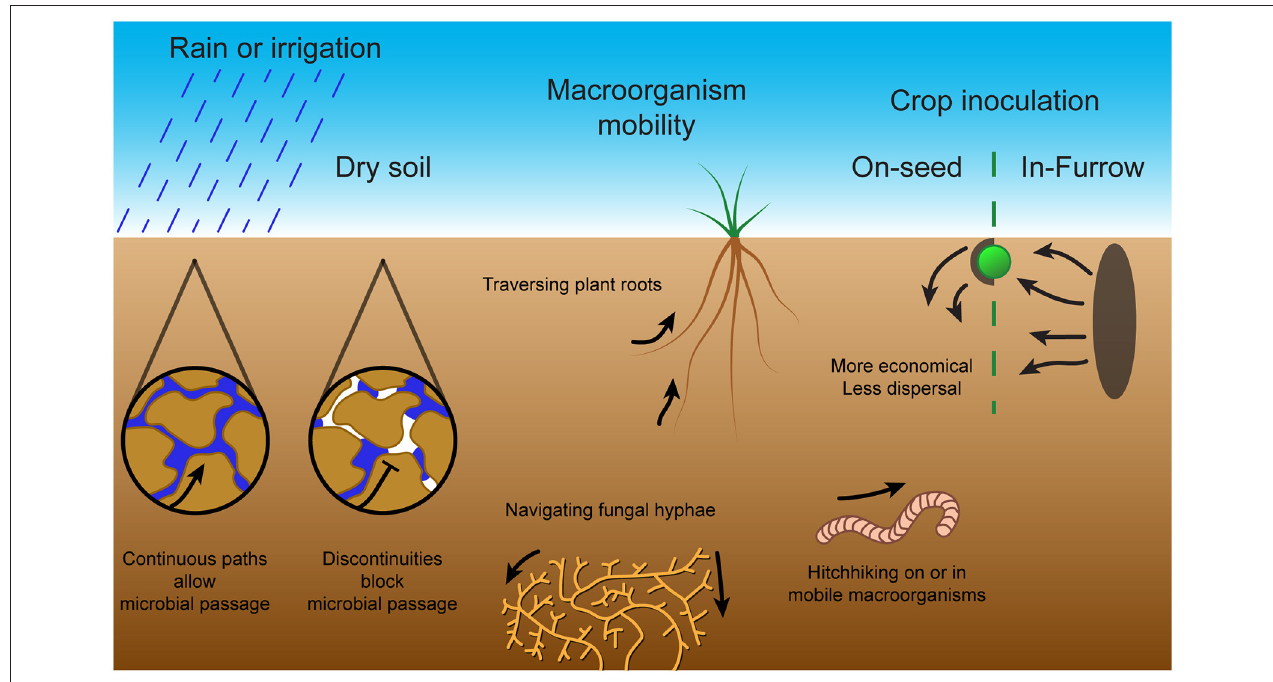
FIGURE 3 | Bacterial mobility methods and challenges in soil. Microbial passage through the soil is dependent on sufficient moisture content to produce continuous pathways through water. Without rain or irrigation, air pockets form within the soil and prevent microbial passage. To combat this, microbes can exploit macroorganisms through methods including traversal along plant roots, navigation of fungal hyphae or hitching a ride on or in mobile macroorganisms. These mobility methods and challenges in soil are important for symbiont inoculation of crop plants. The two main inoculation techniques are on-seed, which although economical does not provide much dispersal, and in-furrow, which requires large amounts of inoculated soil but provides extensive